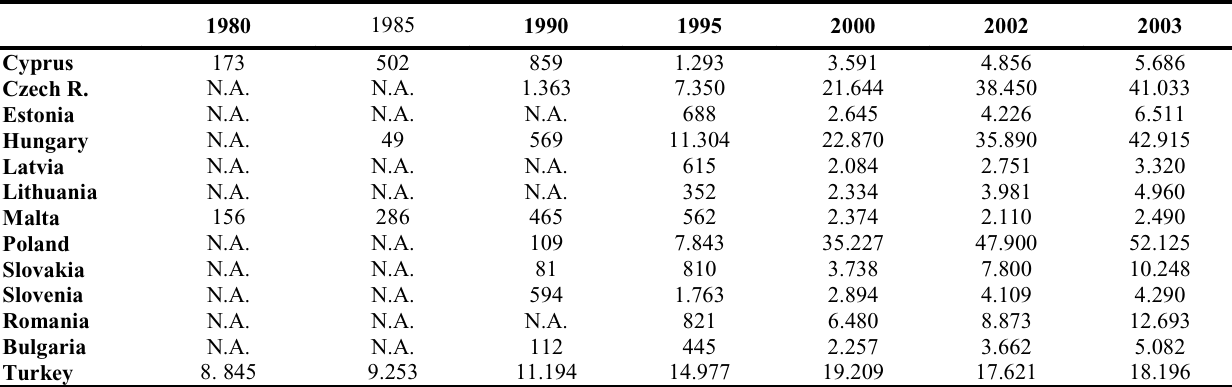
Table 6 . Comparison of Turkey with Romania, Bulgaria and the 10 new members of the EU in terms of FDI stock * between